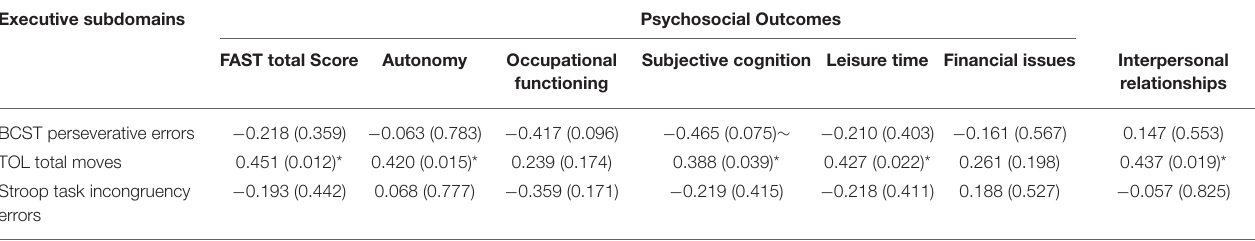
TABLE 4 | Domain specific relationships between executive subdomains and FAST outcomes in the current depression group ( N = 31), expressed by standardized Beta